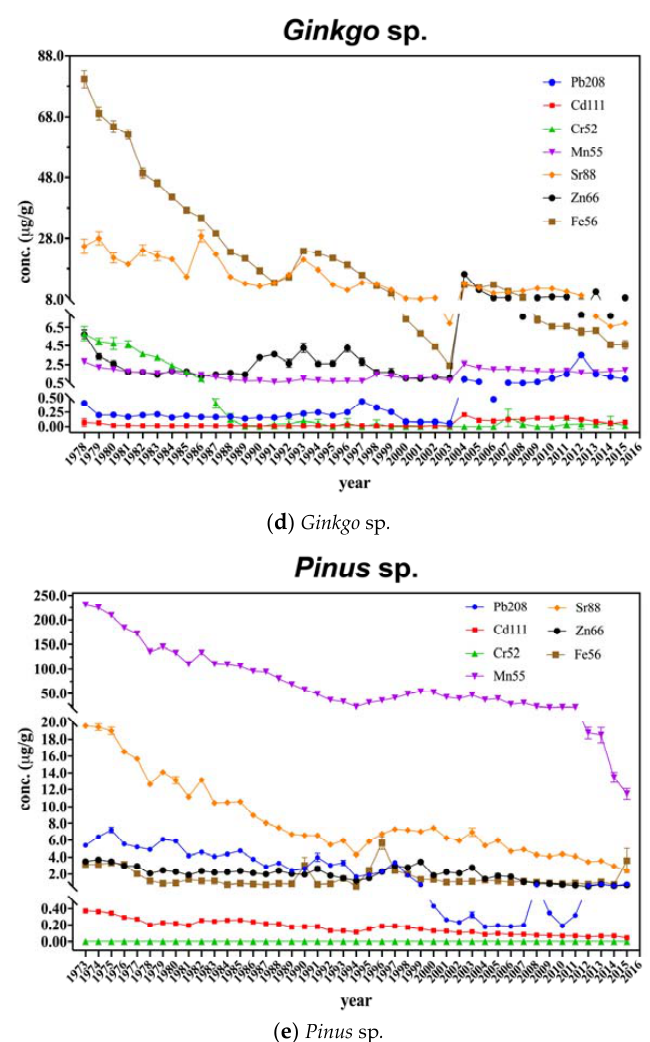
Figure 2. Time ‐ resolved metal concentrations in the tree rings (±standard error). ( a ) Platanus sp., ( b ) Figure 2. Time-resolved metal concentrations in the tree rings ( ± standard error). ( a ) Platanus sp., Salix sp., ( c ) Chamaecyparis sp., ( d ) Ginkgo sp . , ( e ) Pinus sp . ( b ) Salix sp., ( c ) Chamaecyparis sp., ( d ) Ginkgo sp., ( e ) Pinus